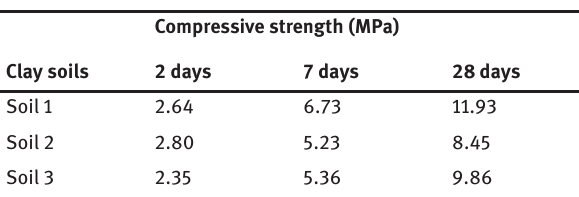
Table 5: Atterberg limits of the studied mixtures.